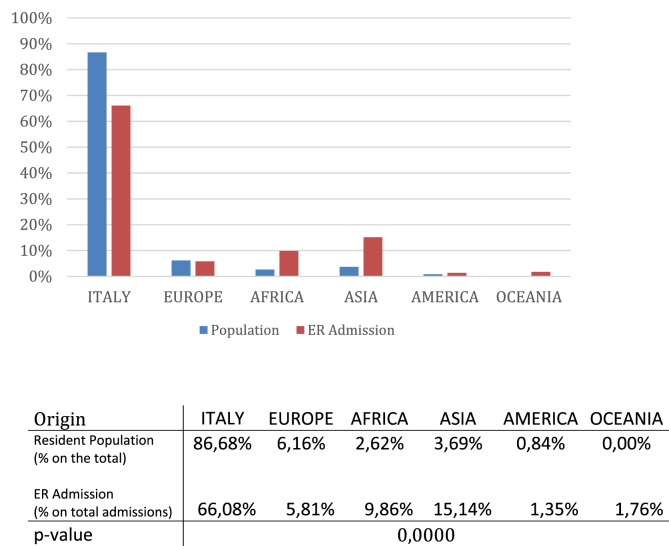
ER admissions vs residents stratified by origin.